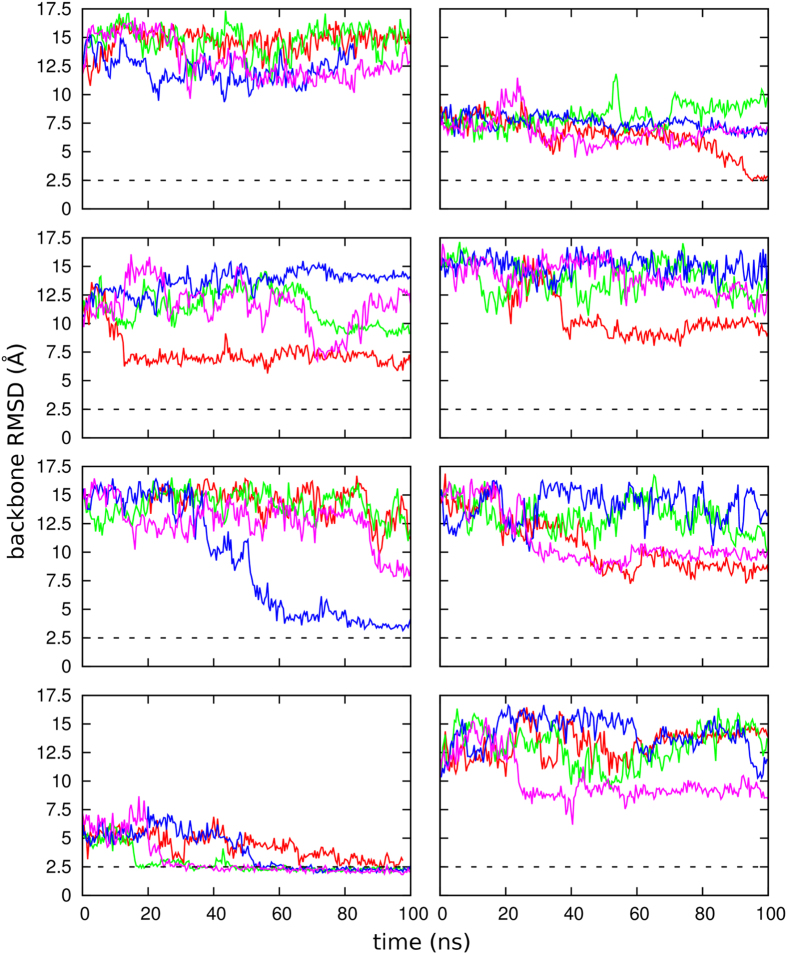
Evolution of the backbone RMSD with respect to the crystallographic complex during a total of 32 unbiased MD simulations started from 8 different structures (corresponding to the different panels) in basin S2.